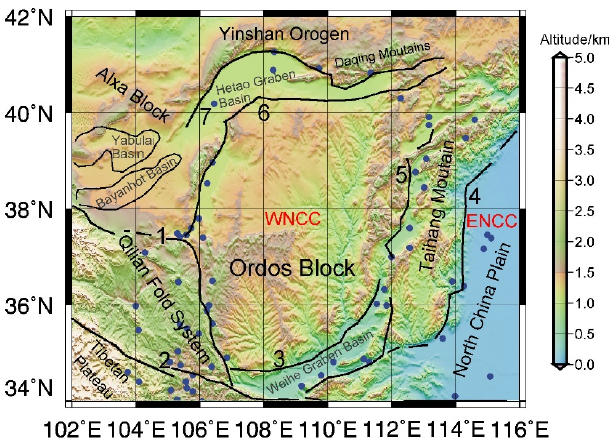
Figure 4. Topography, tectonics, and seismicity of the Ordos region. Blue dots indicate epicenters of